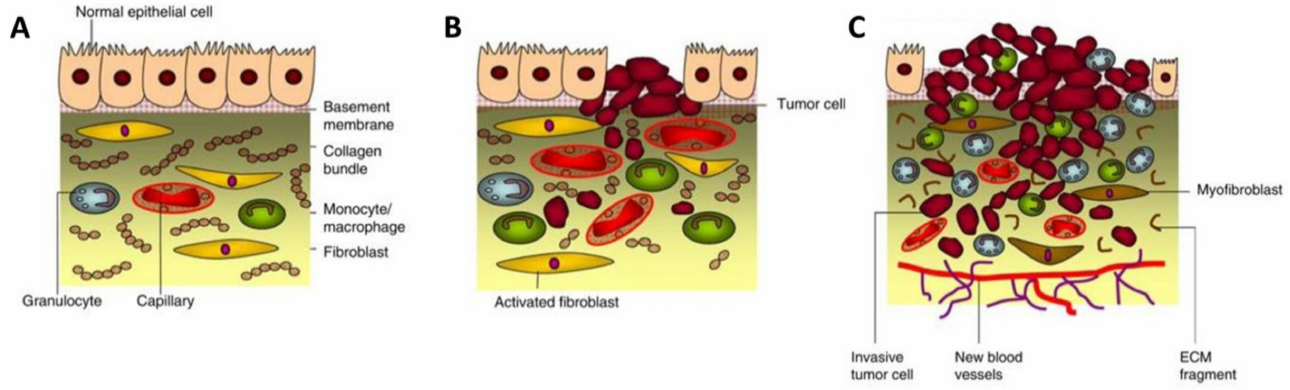
Figure 2. Tumorigenesis. ( A ) Normal epithelium with stromal compartment, including normal epithelial cells, basement membrane, macrophages, fibroblasts, and general ECM components. ( B ) Dysplasia; a process during tumorigenesis where the modified epithelial and stromal cells start excessively propagating and mutating due to cancer invasion. At this stage, the fibroblasts become activated, and macrophages are decreased. ( C ) Carcinoma; the ECM is degraded while the angiogenesis is formed to supply nutrients and oxygen to the tumor area, leading to the continual unregulated proliferation of cancer cells. The figure is reproduced and adapted with permission from